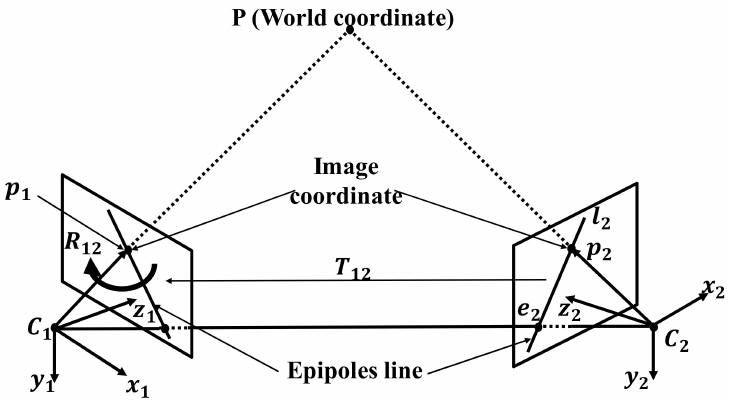
Figure 3. Schematic diagram of two cameras’ stereo calibration for dynamic workpiece